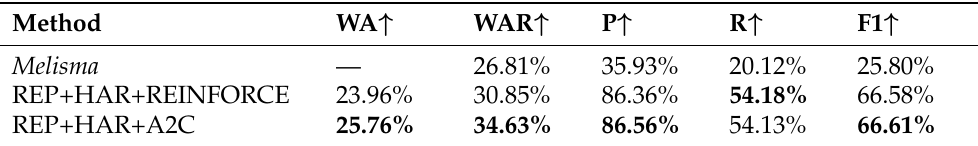
Table 2. The results of all the models in structure segmentation task. The results are the average over five